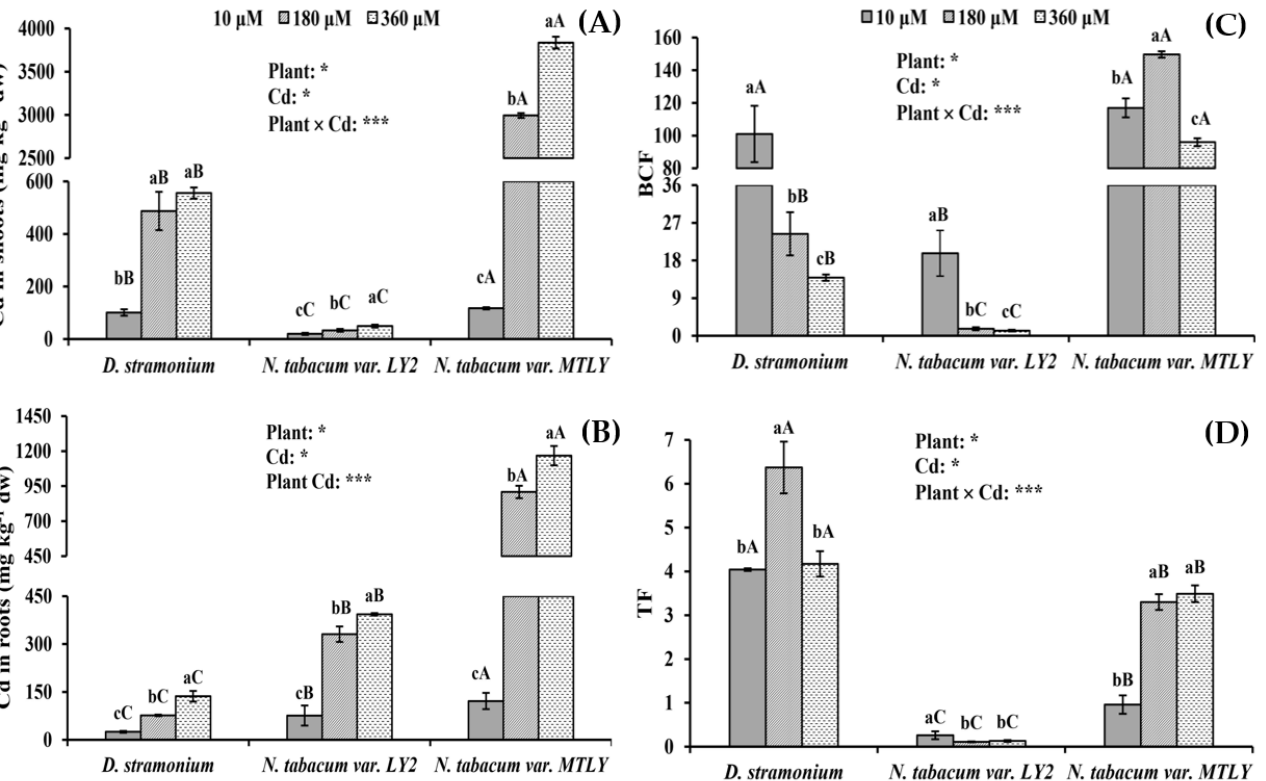
Figure 3. Cd accumulation and translocation in seedling tissues. Cd contents in shoots ( A ) and roots ( B ). Bioconcentration factor (BCF) of Cd in the shoots ( C ). Translocation factor (TF) of Cd from root to shoot ( D ). Values were expressed as means ± SD ( n = 9). Di ff erent lowercase le tt ers on the bars indicated signi fi cant di ff erences between the same material under di ff erent Cd concentrations. Different uppercase le tt ers on the bars indicated signi fi cant di ff erences between di ff erent materials under the same Cd treatment ( p < 0.05). GLM was used to assess the e ff ects of plant materials, Cd treatments and their interactions on test results. The signi fi cance was indicated as follows: * 0.01 < p ≤ 0.05; *** p ≤ 0.001.